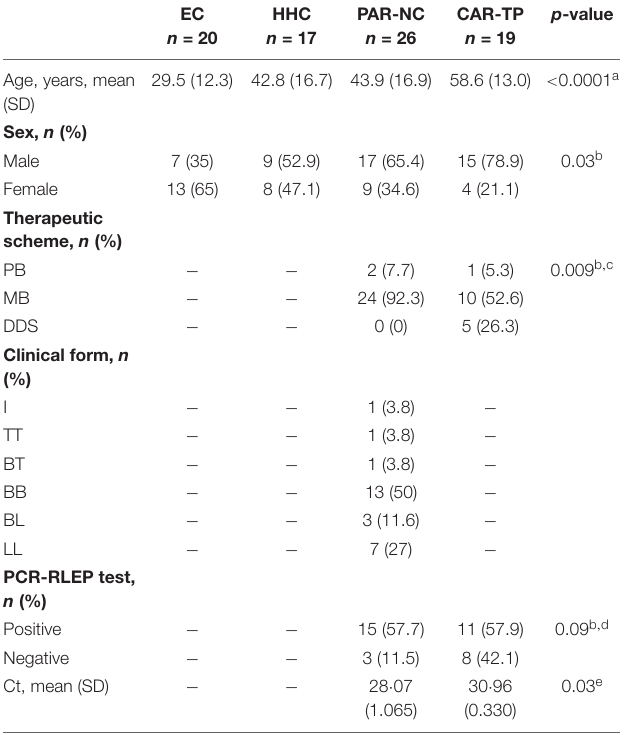
TABLE 1 | Study population characteristics ( N =